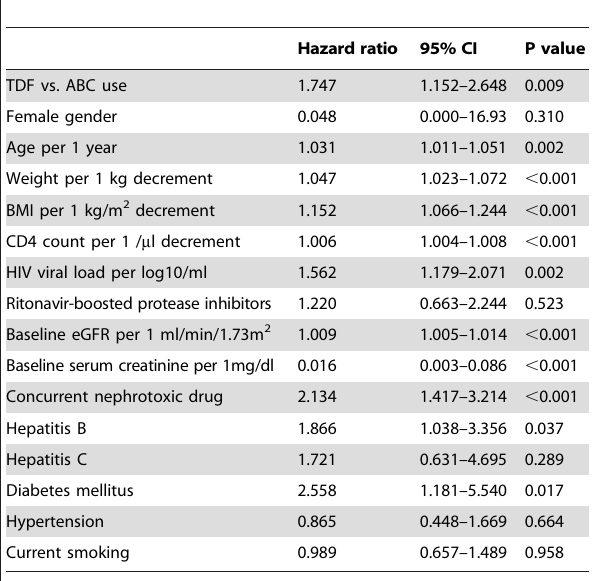
Table 2. Univariate analysis to estimate the risk of various factors in inducing more than 25% fall in eGFR.